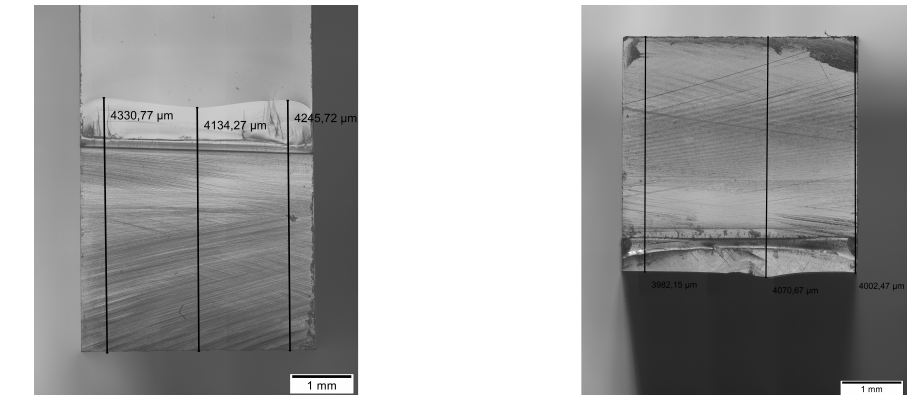
Figure 12. Exemplary machined notch and pre-crack for ( left ) mode I and ( right ) mode II.